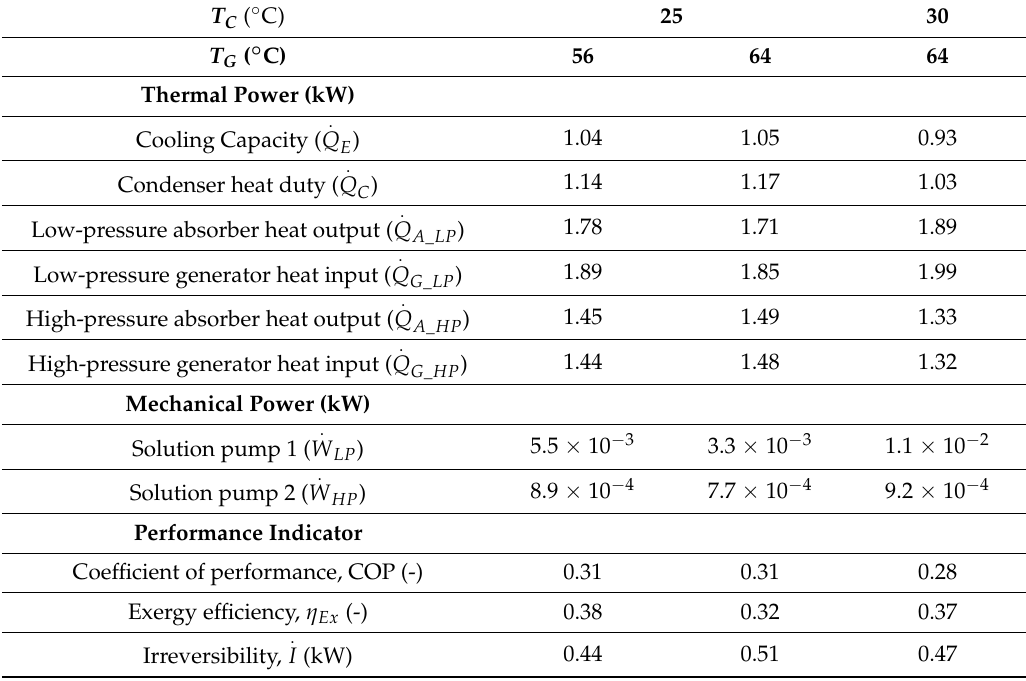
Table 3. Performance summary of the modeling of well W1 coupled to a half-effect cooling system. Case study: Refrigeration ( T E = − 6, PF = 0.7).